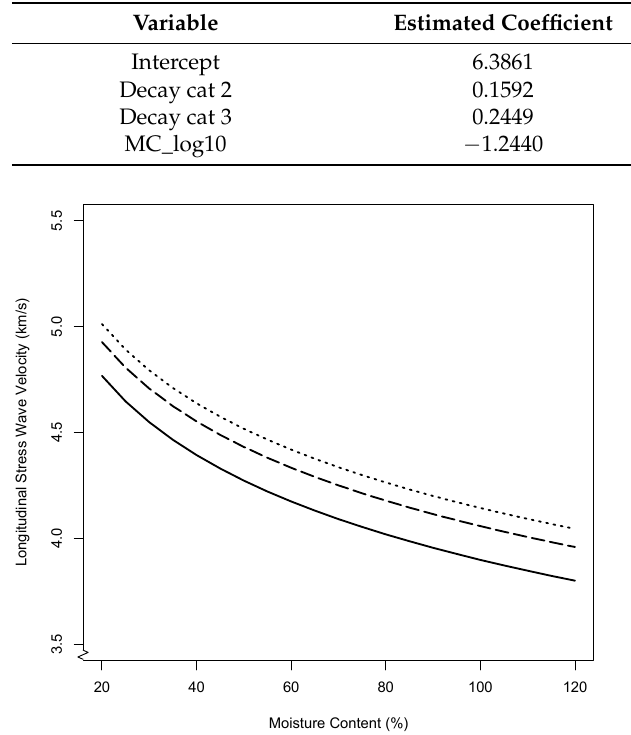
Figure 6. Modeled effect of moisture content (% by oven-dry weight) on longitudinal acoustic velocity (km/s) for visual categories 1 (live trees, solid black line), 2 (dead with no visible green foliage, dashed black line), and 3 (dead with poorest visual appearance, dotted black line).